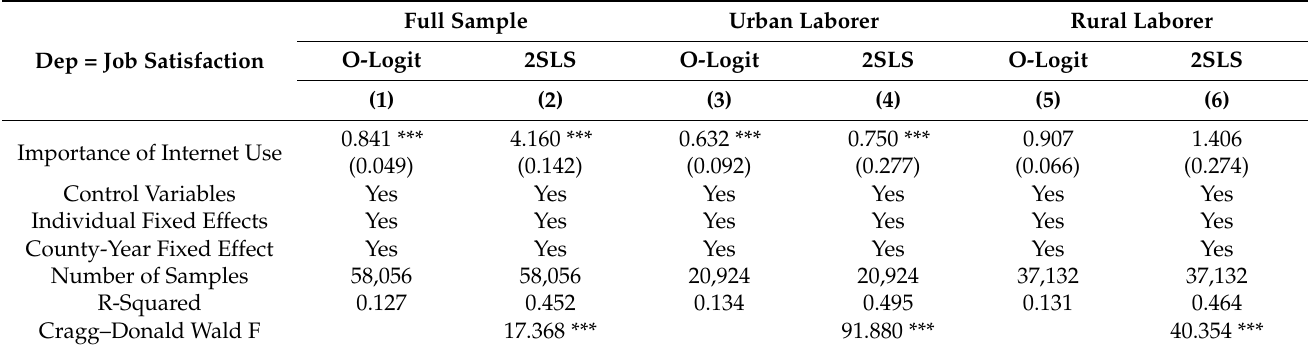
Table 9. Robustness Test: The Impact of Internet Use Importance on Job Satisfaction.